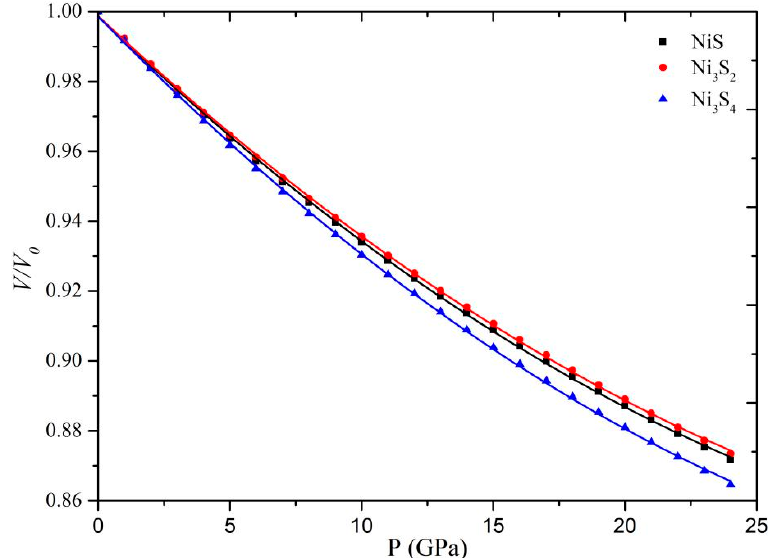
Figure 2. Pressure dependence of unit cell volume for millerite, heazlewoodite, and polydymite.